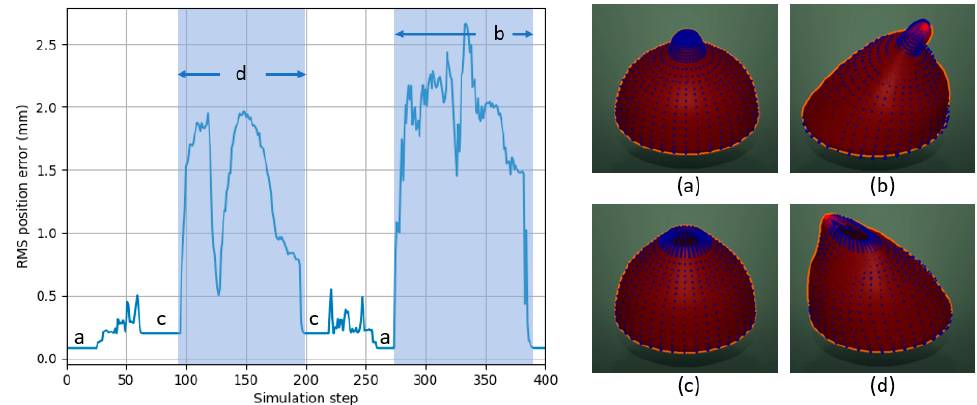
Figure 12. Root mean square position error of the cervix model over simulation time steps: ( a ) the cervix model is closed; ( b ) a user is pulling the cervix model to the right; ( c ) the cervix model is dilated; ( d ) a user is pulling the dilated cervix model to the left.